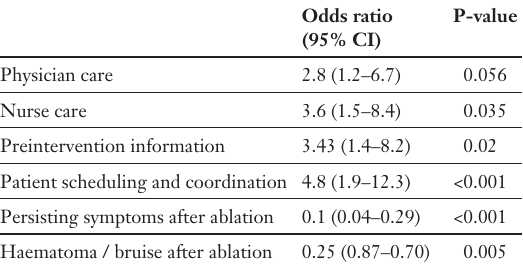
Medical information prior to the procedure 0.38